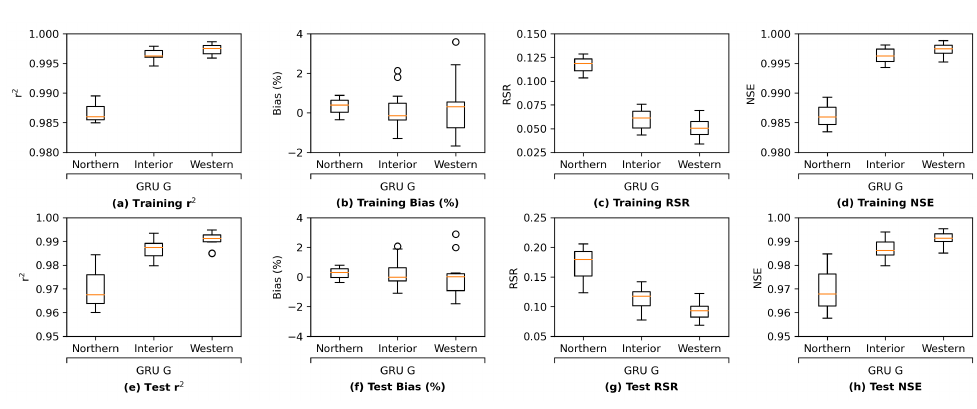
Figure A17. Box and whisker plots of four types of metrics consisting of r 2 , percent bias, RSR, and NSE on stations belonging to the northern, interior, and western Delta groups during the training (panels ( a – d )) and test (panels ( e – h )) phases of the grouped (G) GRU